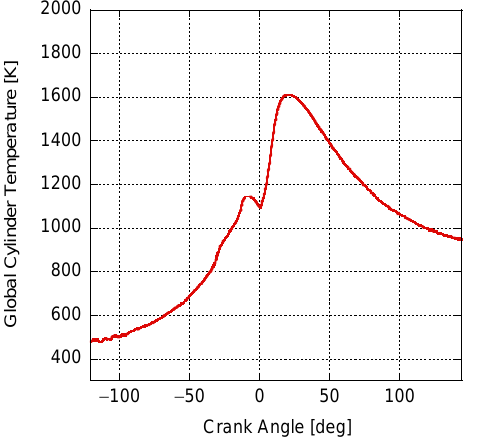
Figure 4. The global in-cylinder temperature computed from the ideal gas law.